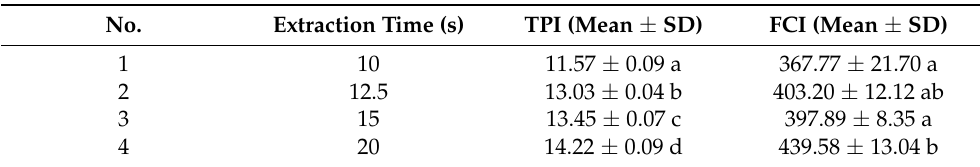
Table 3. Mean values (mean standard deviation, n = 2) for TPI (Total Polyphenolic Index) and FCI (Folin–Ciocalteu Index, ppm gallic acid) measurements from the additional microwave extraction experiments (400 g/L pineapple, 350 W, 60 °C).